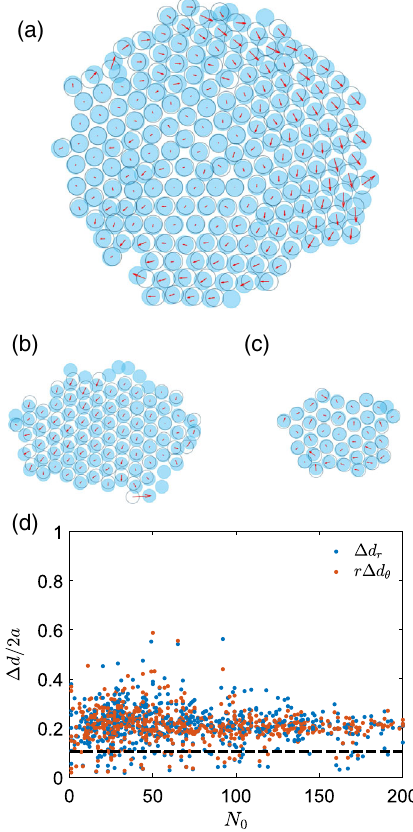
FIG. 8. Nonaffine motion of particles before breakup. (a) – (c) Comparison of rotation-corrected particle positions at the start of spin-up (dark blue circles) and just before shape ¼ E change (i.e., one frame before E , plotted as light- rot rot ; max blue filled circles), for three rafts of varying size. Red arrows show the local displacement field from initial to final particle position. (d) Plot of average displacement of particles (averaged over all particles in the raft) during spin-up Δ d as a function of N 2 a . Displacement has 0 , normalized by the particle diameter been resolved into the radial ( Δ d r , blue data points) and azimuthal ( r Δ d θ , orange data points) directions. The black dashed line indicates the noise floor for particle